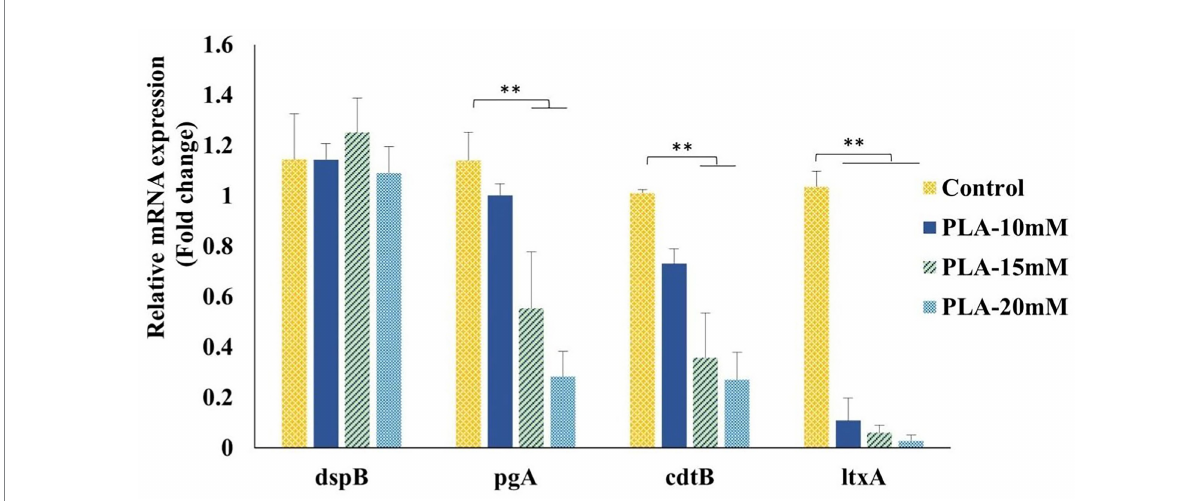
FIGURE 2 Effects of PLA on A. actinomycetemcomitans gene expressions when used at 10, 15, and 20 mM. Total mRNA was isolated, cDNA levels were determined by RT-qPCR, and Ct values were normalized to 16sRNA data. Data are expressed in terms of fold changes relative to the control (BHI/ YE media without a test sample). Data represent the mean value from three independent assays in triplicate, and error bars represent the standard deviation (SD). Differences between groups were determined via one-way ANOVA. ** p < 0.05 between the groups represented in the figure.